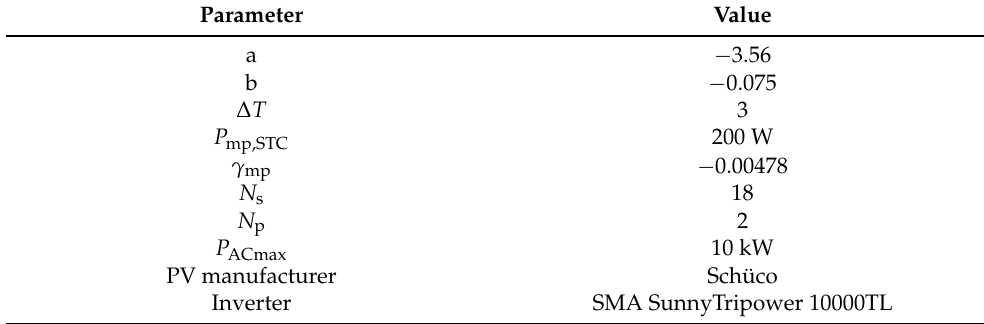
Table 1. PV system data.